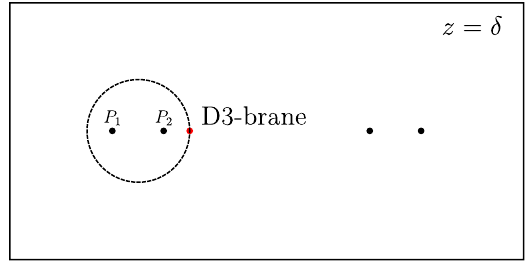
Figure 4 . The red dot represents the D3-brane probe. There is a 3-7 string connecting the D3- brane and the non-abelian seven brane at z = 0. The dashed circle represents the loop around one pair of the splitting roots P 1 and P 2 where the I 1 locus intersect the z = (cid:14) plane. Note that the precise location of the D3-brane and the shape of the loop are irrelevant as long as they all lie within a small neighborhood of P 1 and P 2